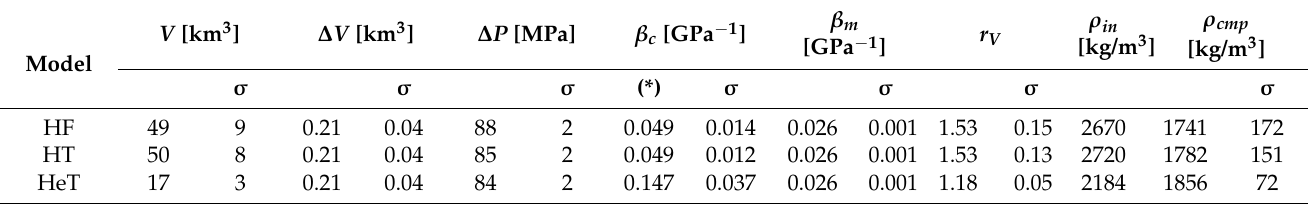
Table 4. Density values of the intrusion, and associated uncertainties estimates σ , obtained from the inversion of residual gravity for 1982–1999.